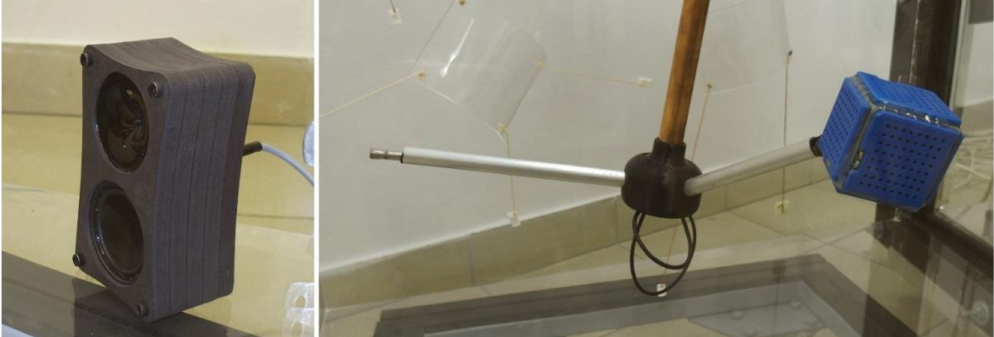
Figure 3. High-frequency sound sources: Architected Sound XS in the source room ( left ) and Architected Sound Omni Blue in the receiving room ( right